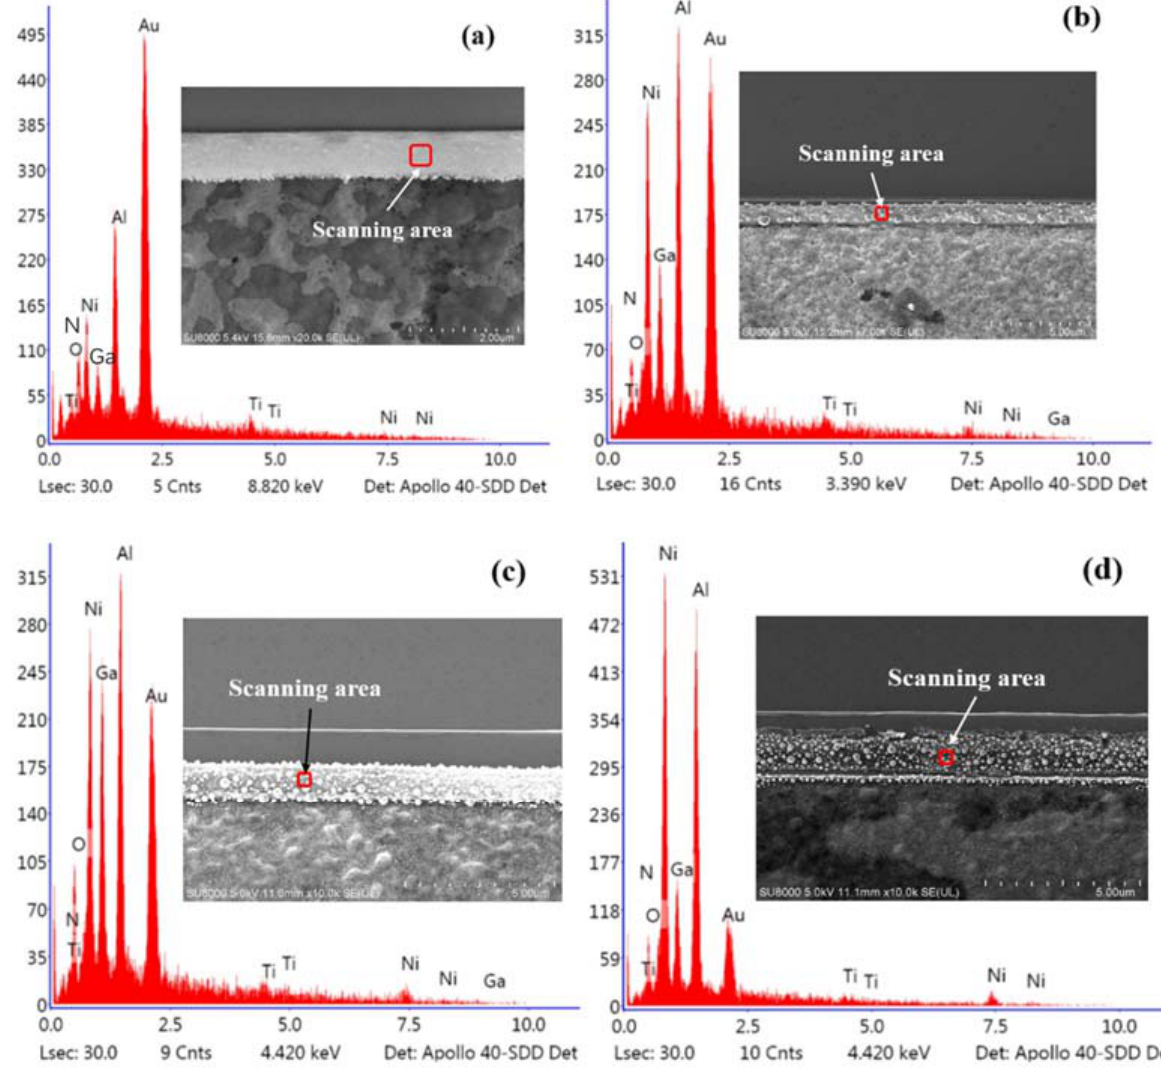
Figure 11. The EDS spectra of TLM electrodes at the annealing temperature of ( a ) 700 °C, ( b ) 750 °C, ( c ) 800 °C, and ( d ) 850 °C.